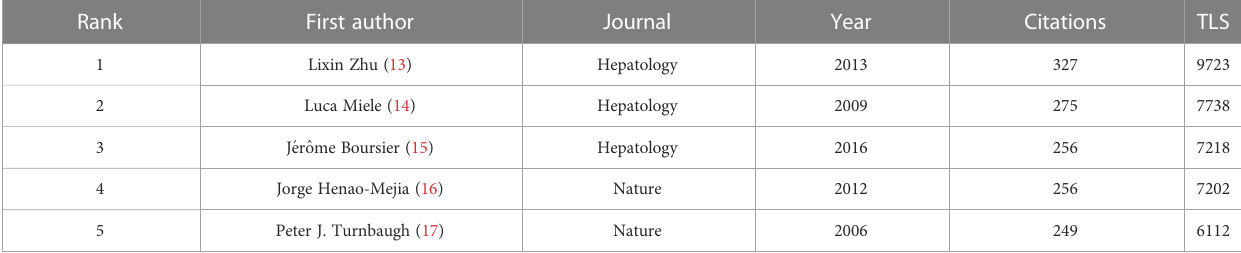
TABLE 6 The top 5 most co-cited references related to the gut-liver axis in NAFLD.